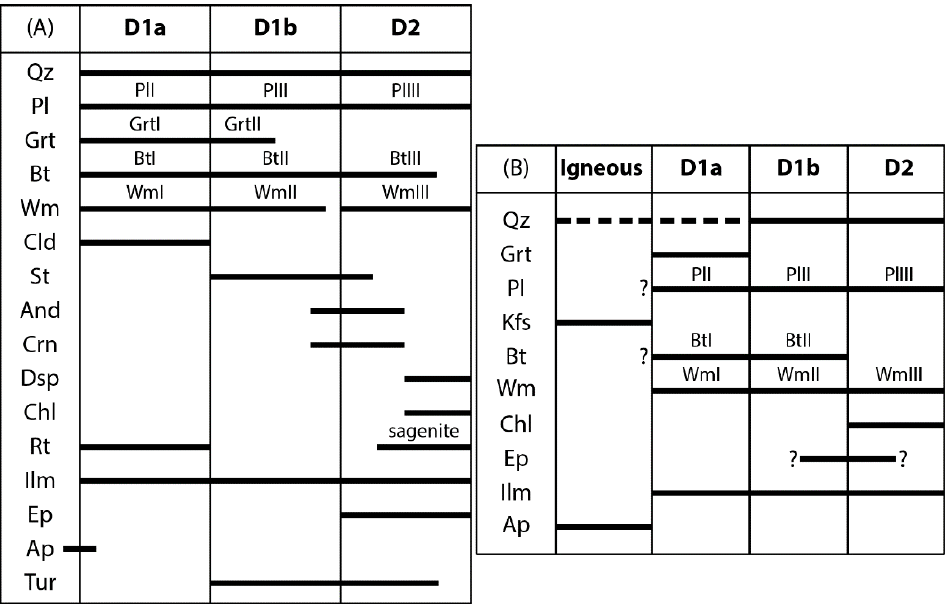
Figure 6. Deformations stages versus mineral growth in metapelites ( A ) and metagranitoids ( B ). Mineral abbreviations are from [51].